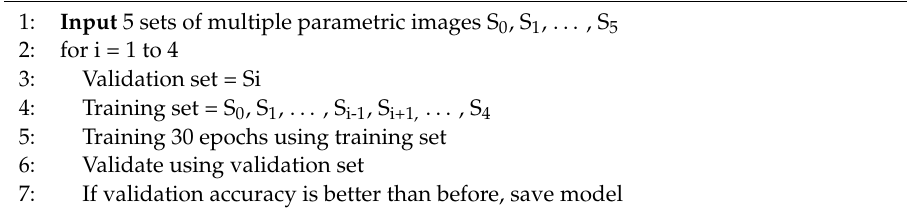
Algorithm 2 Training Procedure